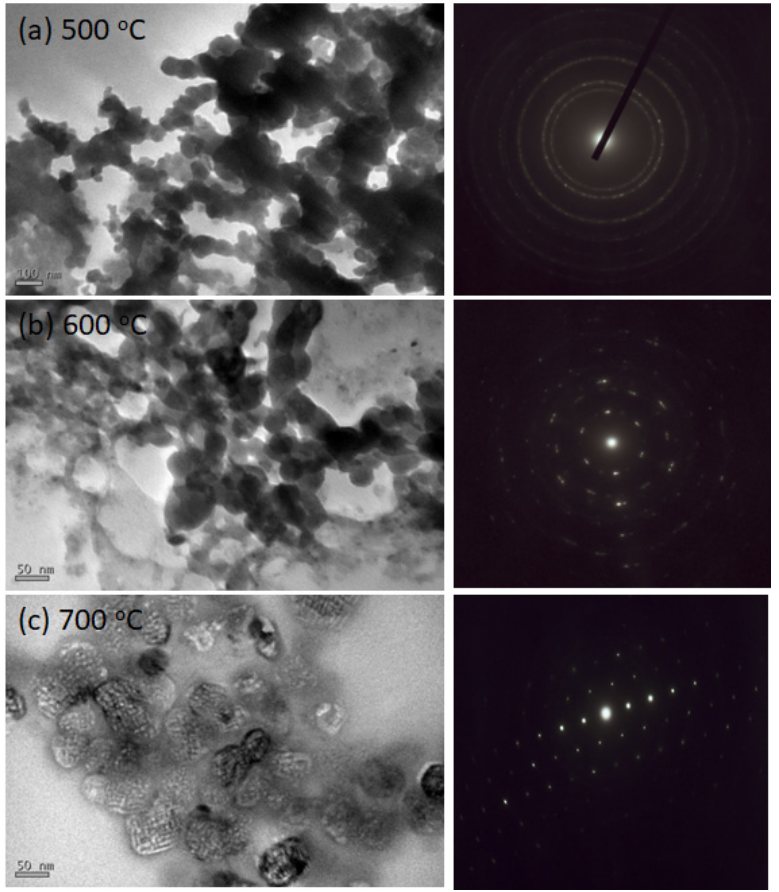
Figure 9. Plan-view TEM images of three samples and their electron diffraction patterns: ( a ) T1: 500 °C, ( b ) T2: 600 °C, and ( c ) T3: 700 °C. 500 ◦ C, ( b ) T2: 600 ◦ C, and ( c ) T3: 700 ◦